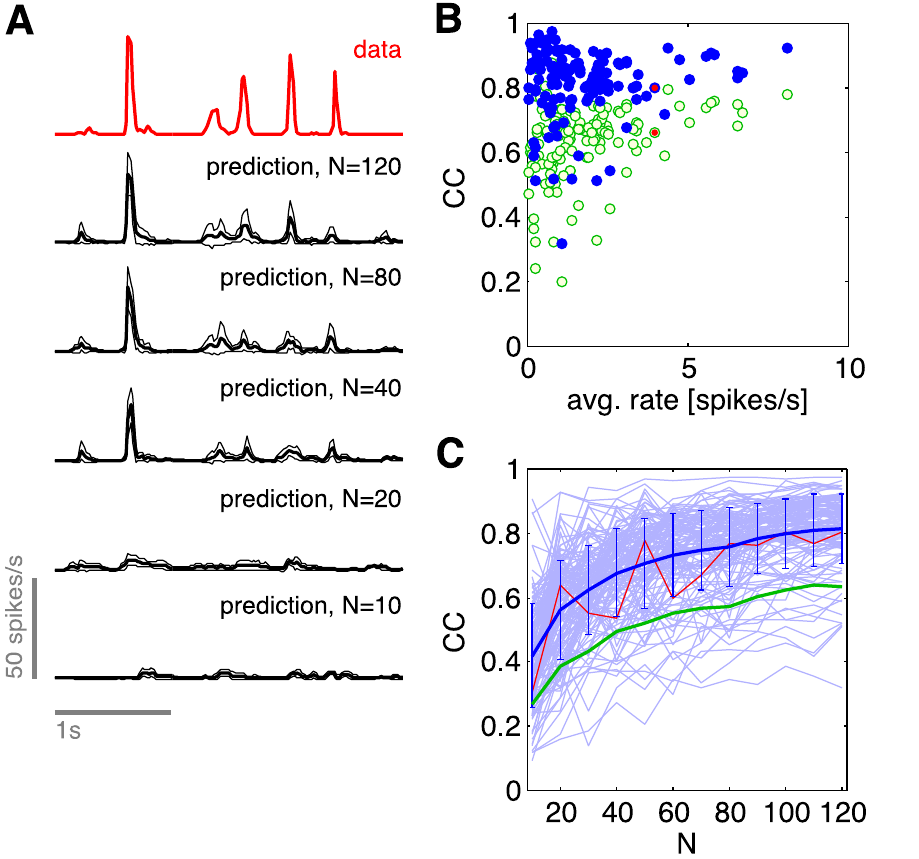
Figure 15. Predicting the firing probability of a neuron from the rest of the network. ( A ) Probability per unit time (spike rate) of a single neuron. Top, in red, experimental data. Lower traces, in black, predictions based on states of other neurons in an N –cell group, as described in the text. Solid lines are the mean prediction across all trials, and thin lines are the envelope 6 one standard deviation. ( B ) Cross–correlation (CC) between predicted and observed spike rates vs. time, for each neuron in the N =120 group. Green empty circles are averages of CC computed from every trial, whereas blue solid circles are the CC computed from average predictions. ( C ) Dependence of CC on the population size N . Thin blue lines follow single neurons as predictions are based on increasing population sizes; red line is the cell illustrated in (A), and the line with error bars shows mean 6 s.d. across all cells. Green line shows the equivalent mean behavior computed for the green empty circles in (B).